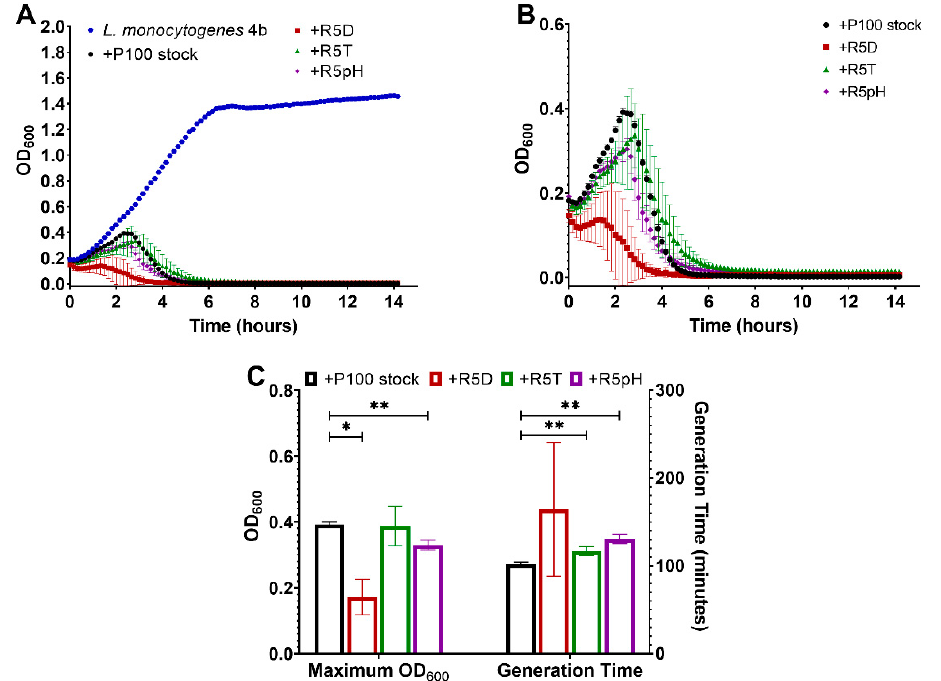
Figure 6. ( A ) Growth curve of an L. monocytogenes serotype 4b sample left uninfected as compared to infection with P100 stock and reversion-tested P100 samples selected for resistance to desiccation (R5D), resistance to high-temperature exposure (R5T), and resistance to low-pH exposure (R5pH). ( B ) Same growth curve of an L. monocytogenes serotype 1/2a sample infected with P100 stock and reversion-tested P100 samples R5D, R5T, R5pH shown at a higher OD 600 resolution to compare the different growth curve trends. ( C ) Maximum OD 600 readings and generation times in minutes for L. monocytogenes serotype 4b samples infected with different P100 bacteriophage samples. Three bio- logical replicates were tested for the different engineered P100 samples, with all experiments being performed in triplicate. Results are shown as average of the biological replicates ± standard devia- tion for the reversion-tested phage, except for the R5D generation time result, and the average of the technical replicates ± standard deviation for the P100 stock. The generation time for one of the R5D biological replicates could not be calculated as there was no measured bacteria growth after infection, thus the results for this sample are given as the average ± standard deviation of two bio- logical replicates. Statistically significant differences compared to the P100 stock are marked as fol- lows: * p ≤ 0.05, and ** p ≤ 0.01. Nomenclature: R5D: P100 sample that underwent 5 cycles of desic- cation selection followed by 5 propagation cycles in the absence of stress; R5T: P100 sample that underwent 5 cycles of high-temperature selection followed by 5 propagation cycles in the absence of stress; R5pH: P100 sample that underwent 5 cycles of low-pH selection followed by 5 propagation cycles in the absence of stress.